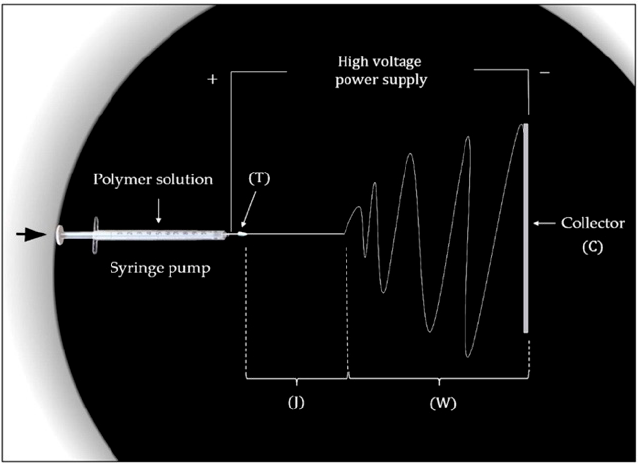
Figure 4. Schematic view of the electrospinning equipment with the four distinct states: Taylor cone formation area (T); stable-straight jet part (J); unstable, whipping region (W); fibers collection phase (C) [87].